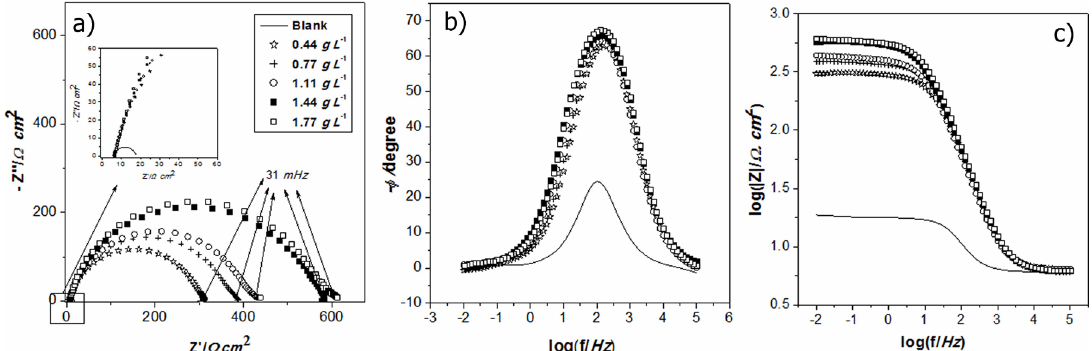
Figure 4. Nyquist (a) and Bode plots, for phase angle (b) and the logarithm of the impedance modulus (c) for carbon steel in the absence and presence of different concentrations of the cocoa bean shell powder in the 0.5 mol L -1 HCl